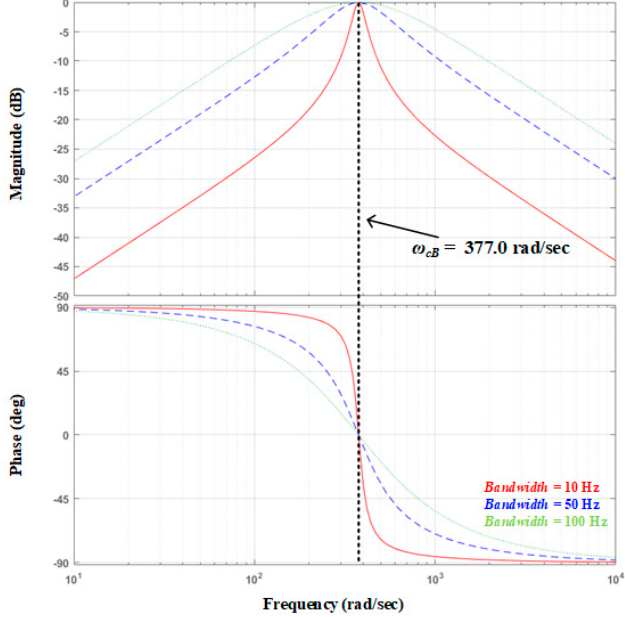
Figure 7. Bode plot of the BPF according to bandwidth in the THE method.